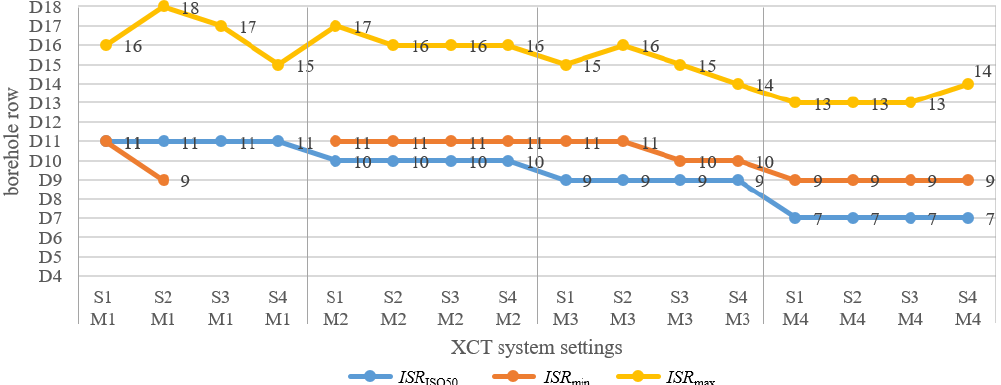
Figure 4. Resulting recognisability of interface structures depending on the XCT system